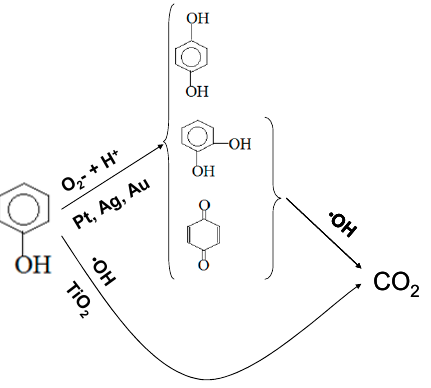
Figure 13. Distinct mechanisms of Phenol (Ph) photocatalytic oxidative conversion over bare and noble metal-modified TiO 2 .